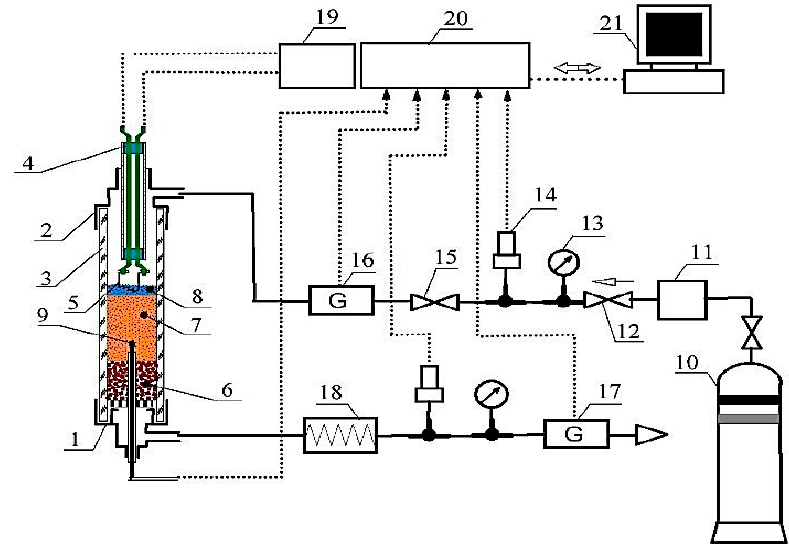
Figure 2. Schematic of the experimental Laboratory flow-type SHS reactor.